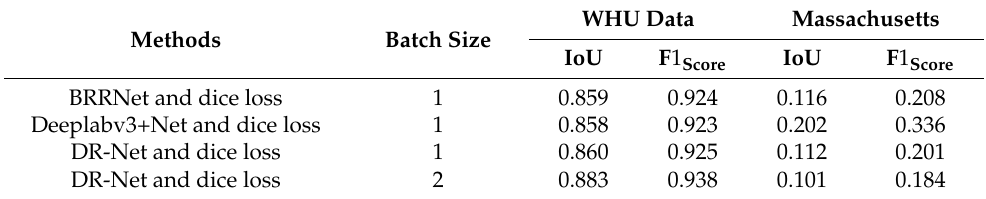
Table 5. The transfer learning of different methods (networks were trained on the WHU data set). The column “Massachusetts” represents the results of the networks that were trained on the training set of the Massachusetts Building Dataset and then tested on the test set of the Massachusetts Building Dataset. The column "WHU set" represents the results of the networks that were trained on the training set of the Massachusetts Building Dataset, and then tested on the test set of the WHU data set. WHU Data Massachusetts Methods Batch Size IoU F 1 Score IoU F 1 Score BRRNet and dice loss 1